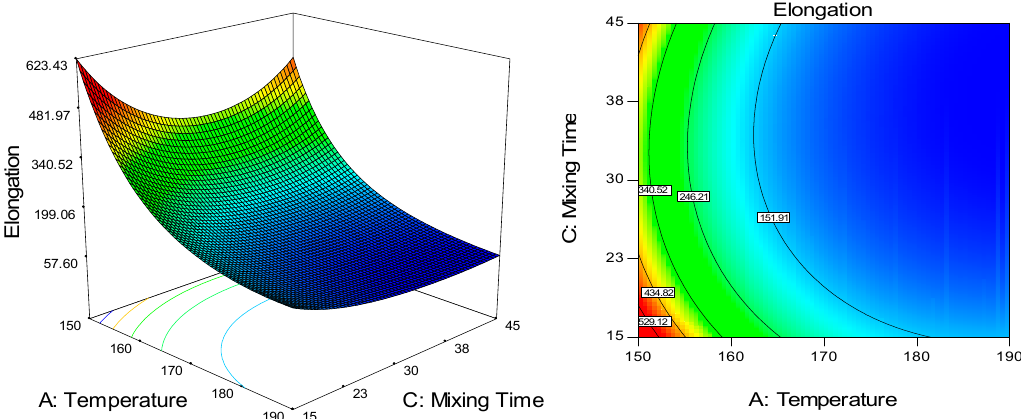
Figure 4. The 3D and contour plot for the dependence of UHMWPE / CNF bionanocomposite’s elongation at break on temperature and mixing time as significant factors.